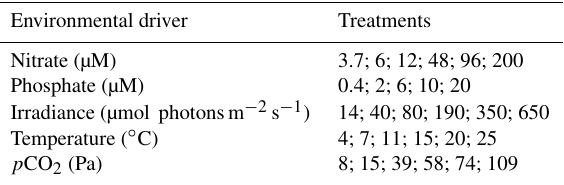
Table 1. Treatment conditions for each environmental driver used in the manipulation